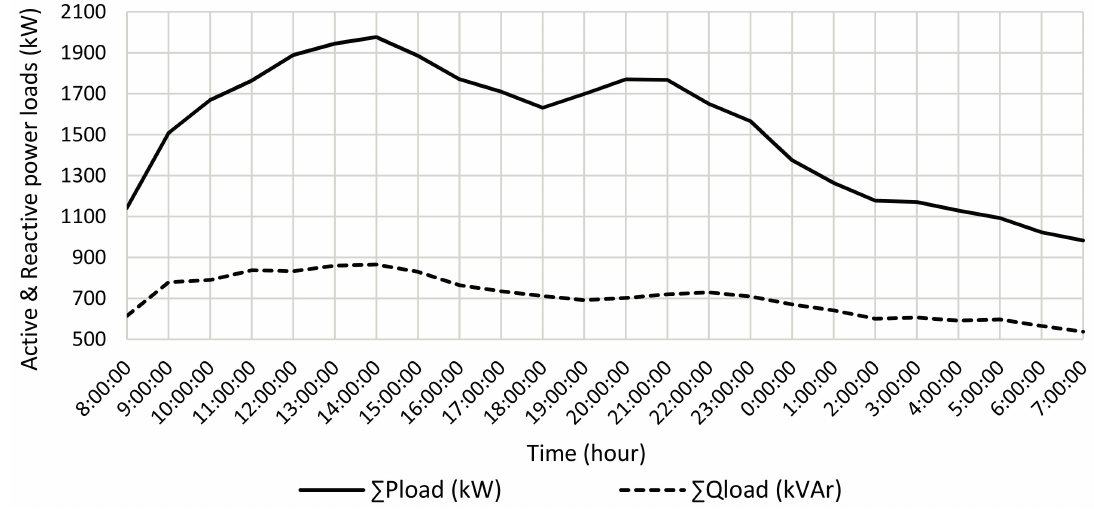
Figure 5. Graph of active and reactive power loads at each bus at 11 kV within